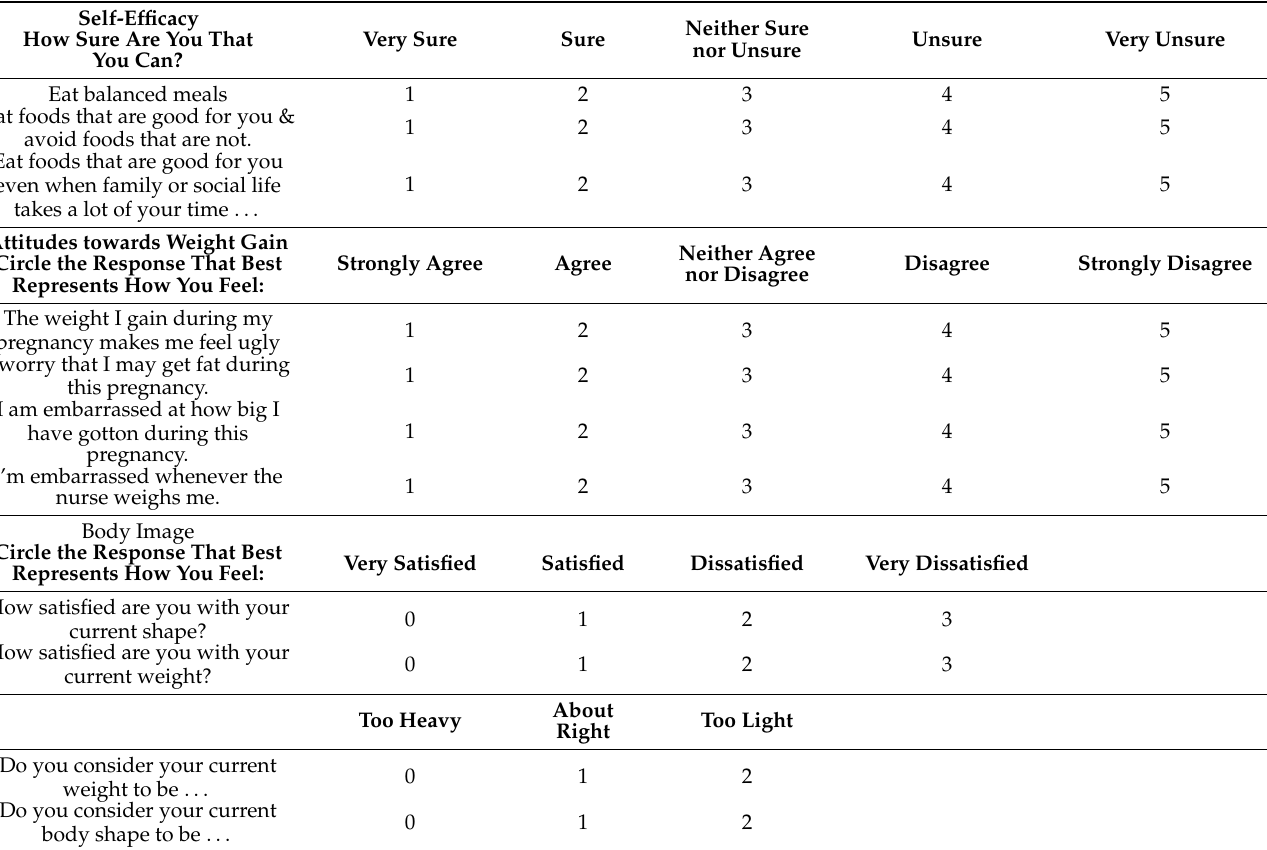
Table 1. Gestational Weight Gain Psychosocial Risk Assessment